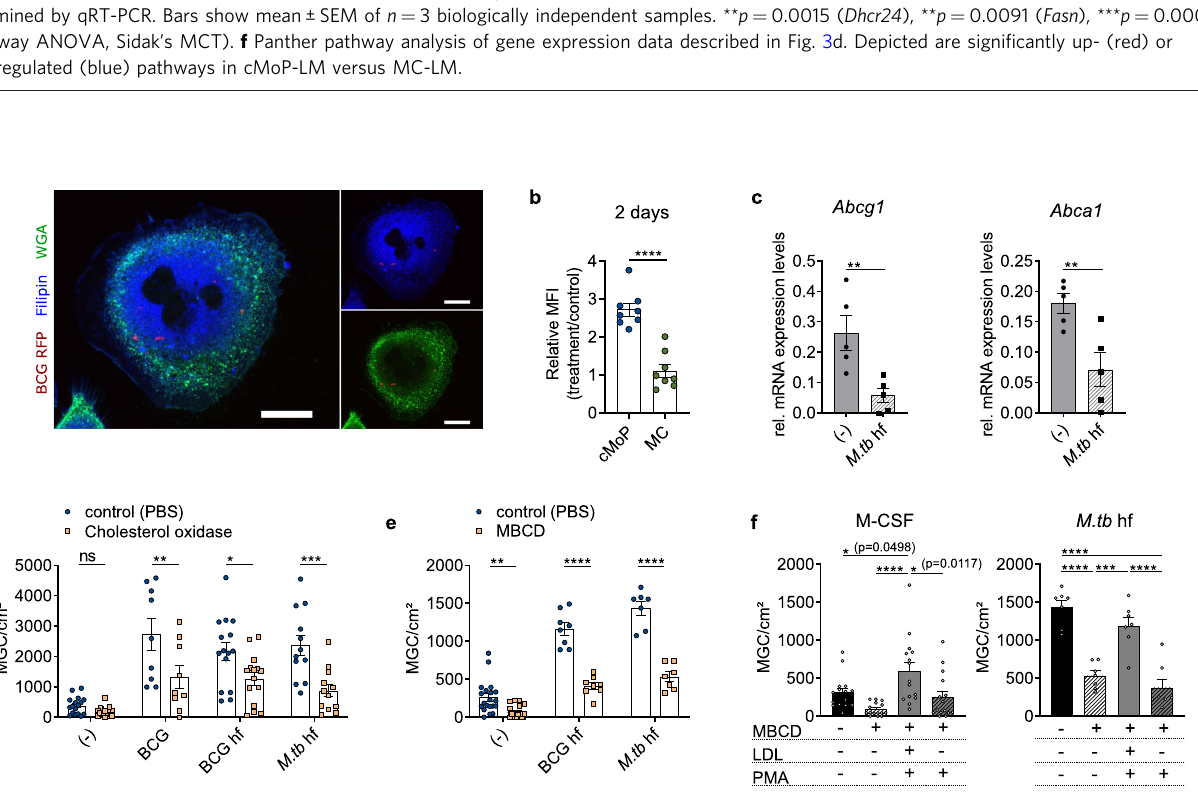
NATURE COMMUNICATIONS| (2021) 12:2027